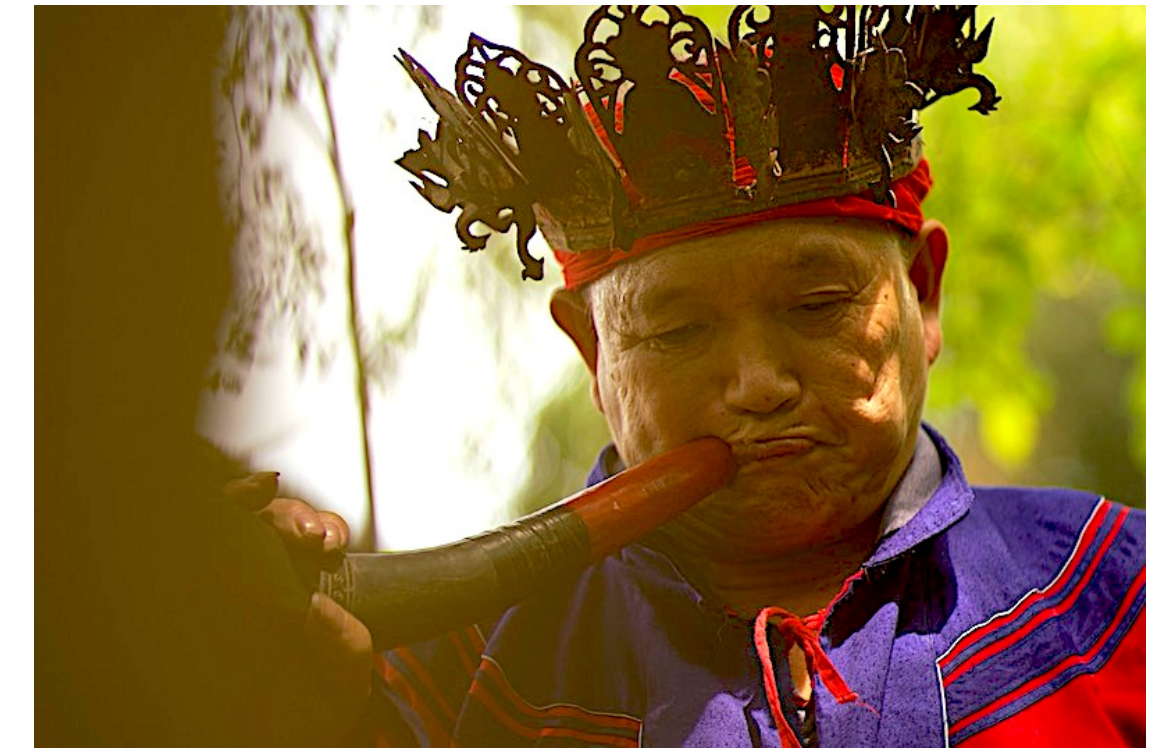
Figure 19. Badai Shi Changwu blowing the water buffalo horn to announce the assault on the straw figures. (Photo: Thomas Riccio).